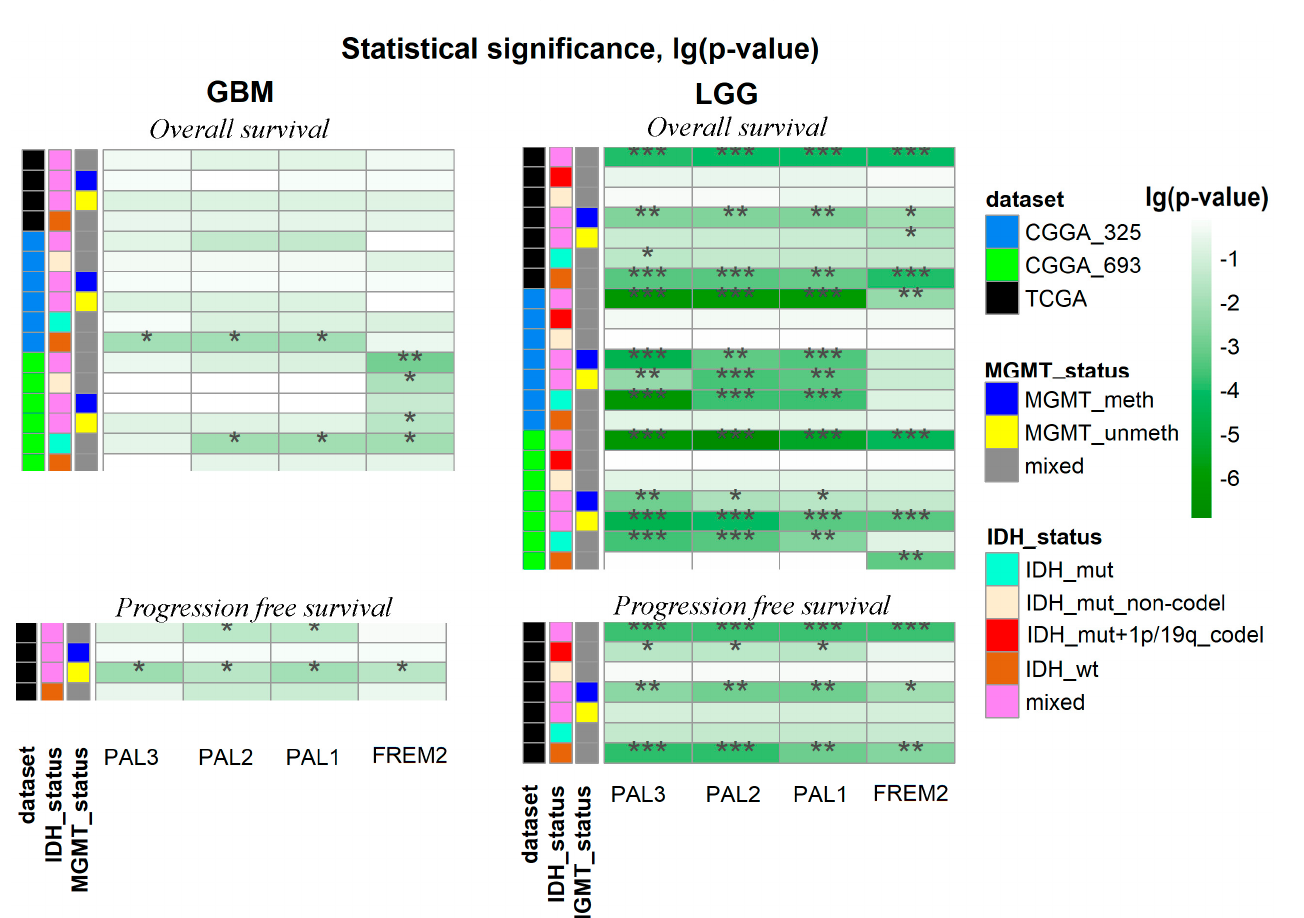
Figure 4. Performance of FREM2 -based survival biomarkers in glioma datasets. Q-values of log-rank test of using FREM2 expression ( FREM2 ), PAL1, PAL2, and PAL3 were investigated as survival predictors in 48 comparisons. Each survival predictor was assessed relatively by its median (high level—the predictor was higher than its median and low level—the predictor was lower or equal to its median). * stands for q < 0.05, ** for q < 0.01, *** for q < 0.001. Color markers indicate dataset under analysis, IDH mutation, and MGMT promoter methylation statuses. “Mixed” stands for groups including samples with both variants of IDH or MGMT statuses. Status “IDH_mut” takes into account only IDH mutation existence, but not 1p/19q codeletion status.